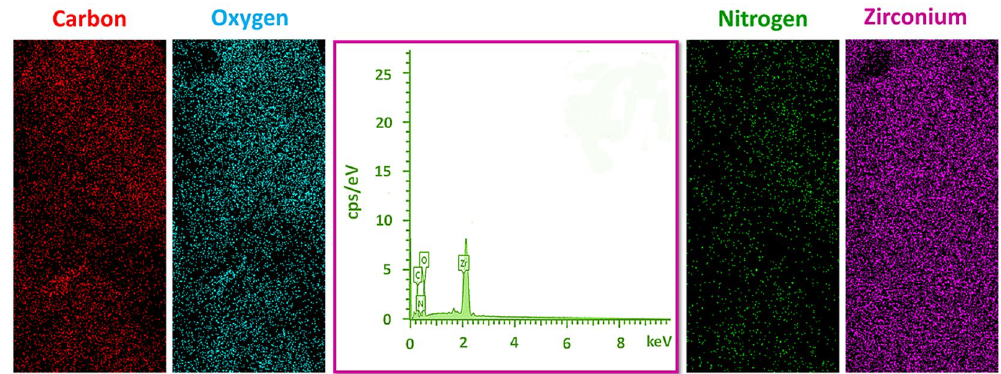
Figure 5. EDX diagram and elemental mapping of the Zr-UiO-66-PDC